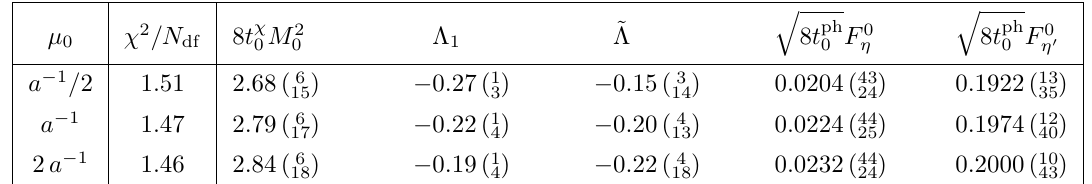
Table 15. Results that depend on Z s